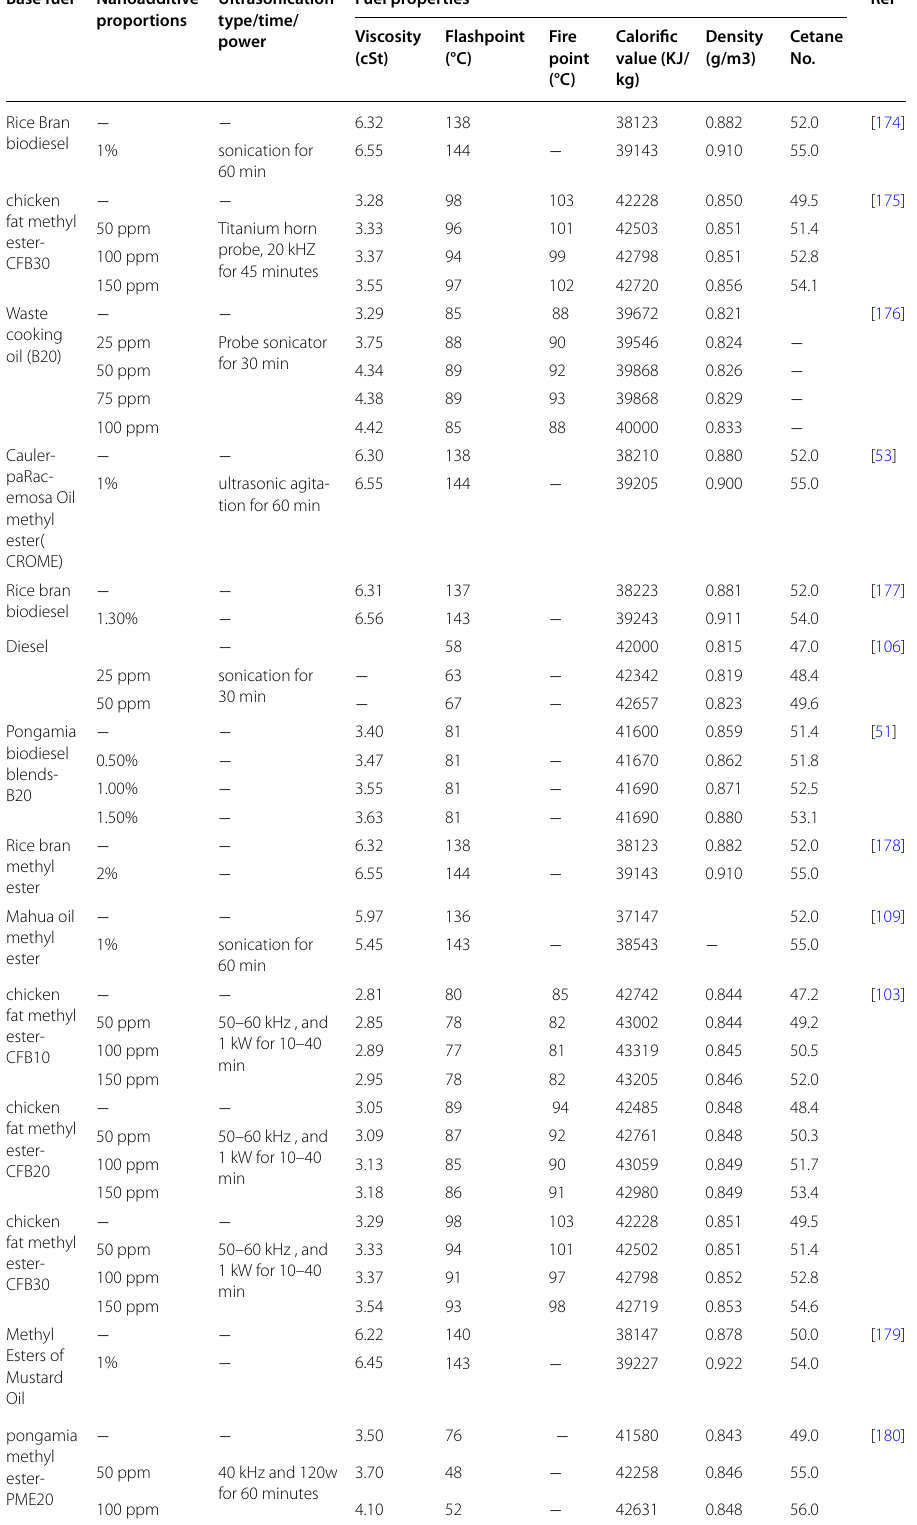
Table 4 Summary of fuel properties of magnetite nano-particles with different concentrations Base fuel Nanoadditive proportions